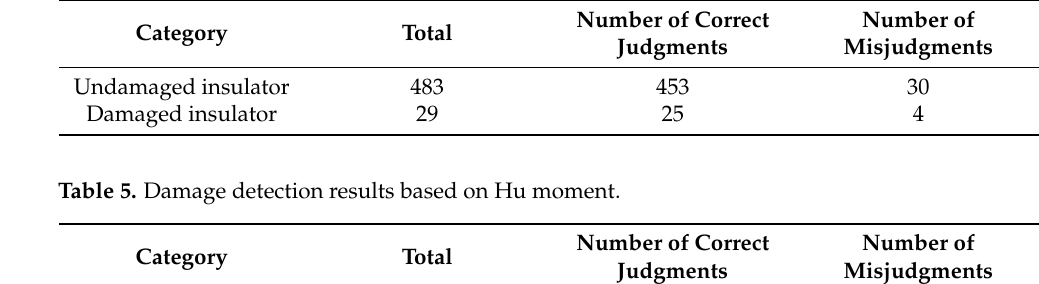
Table 4. Damage detection results based on Zernike moment.